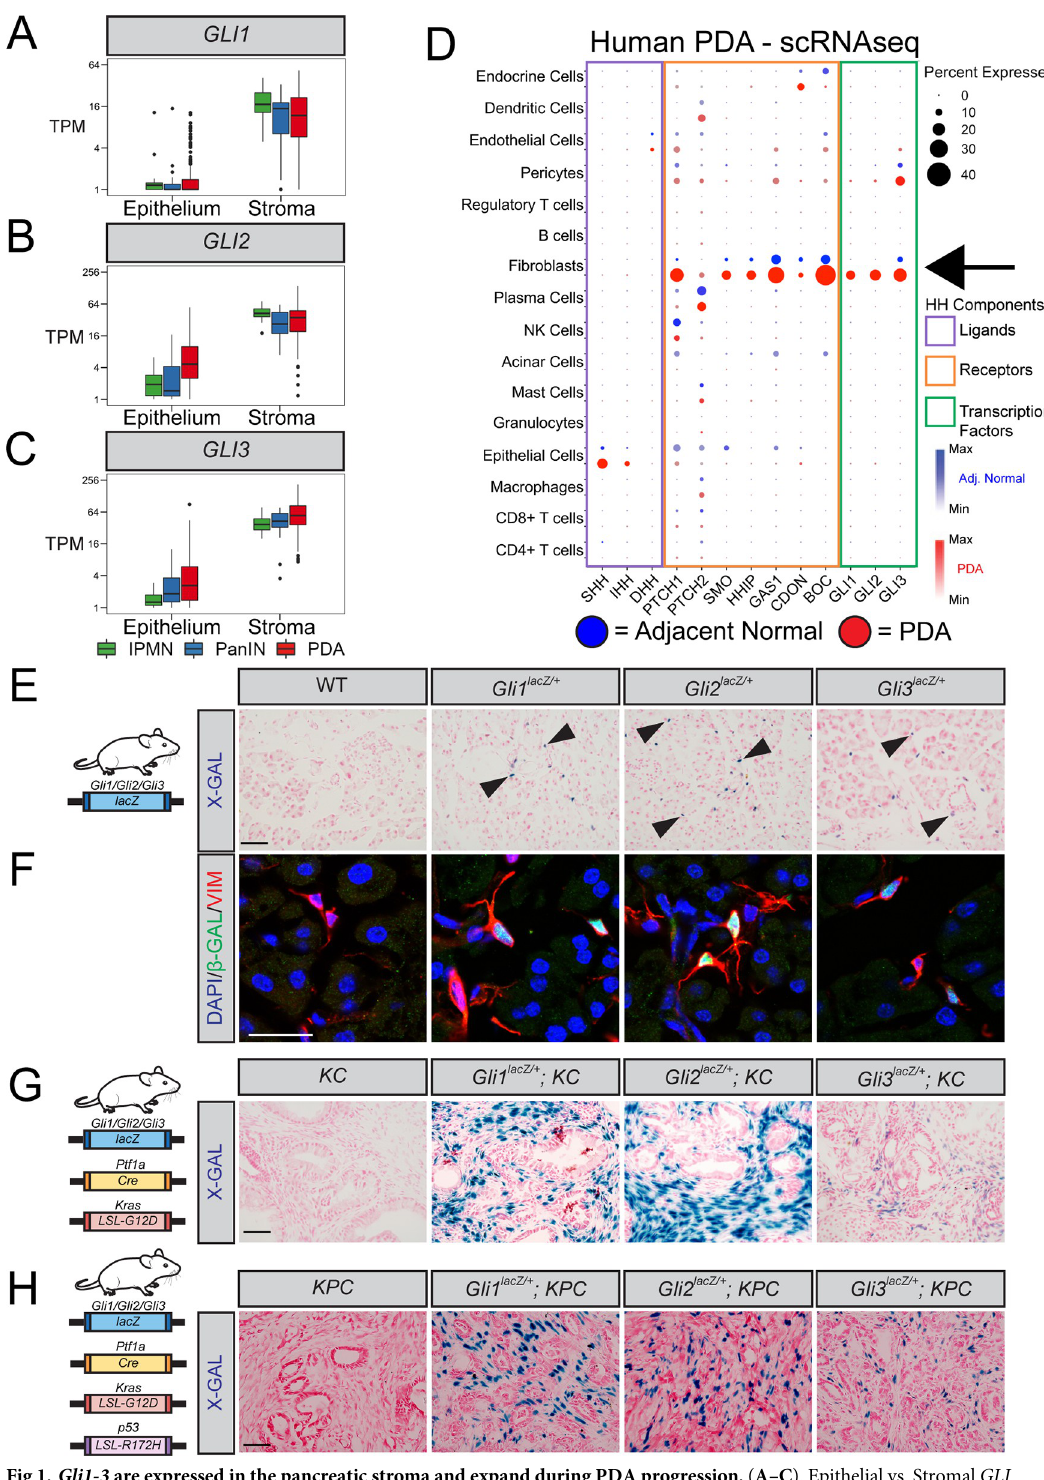
Fig 1. Gli1-3 are expressed in the pancreatic stroma and expand during PDA progression. ( A–C ). Epithelial vs. Stromal GLI expression in human IPMN tissue (green, n = 19 Epithelial, n = 12 Stromal), PanIN (blue, n = 26 Epithelial, n = 23 Stromal), and PDA (red, n = 197 Epithelial, n = 124 Stromal), determined by LCM-RNAseq [40]. ( D ) Expression of HH pathway components in human PDA (red, n = 16) and adjacent normal pancreas (blue, n = 3), determined by scRNAseq [42]. Dot size indicates frequency. Dot color intensity indicates expression level. Boxes outline ligands (purple), receptors (orange), and transcription factors